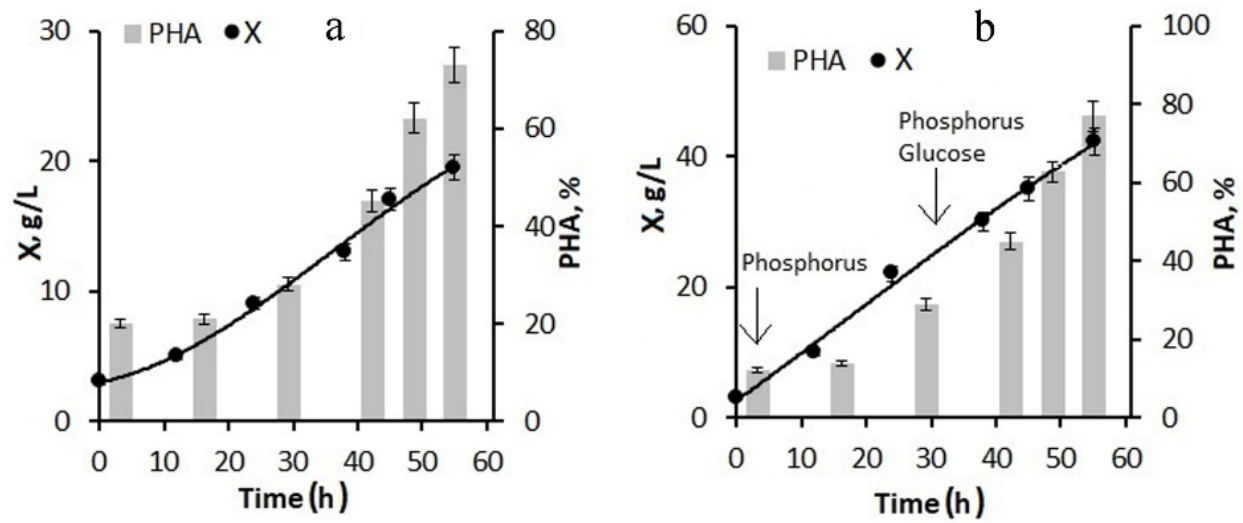
Figure 3. Production parameters of the bacterial culture Cupriavidus necator B-10646 when grown on hydrolyzed sugar beet molasses in the 8 L fermenter under different versions of feeding the culture with nutritive elements: ( a )—20-fold dilution of molasses hydrolysate; culture feeding with phosphorus at the first stage, and feeding with phosphorus + glucose at the second stage; ( b )—20-fold dilution of molasses hydrolysate with feeding the culture with phosphorus and glucose at the first and second stages (indicated by